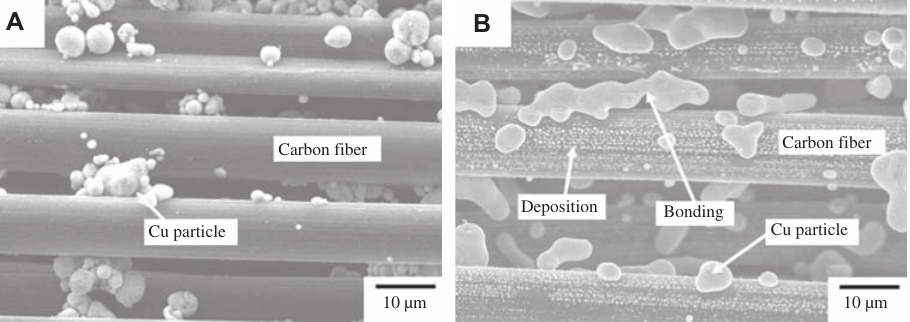
Figure 1 Microstructure of CF preform with different fabrication methods; (A) high temperature sintering process and (B) the SPS sintering at their fabrication temperatures of